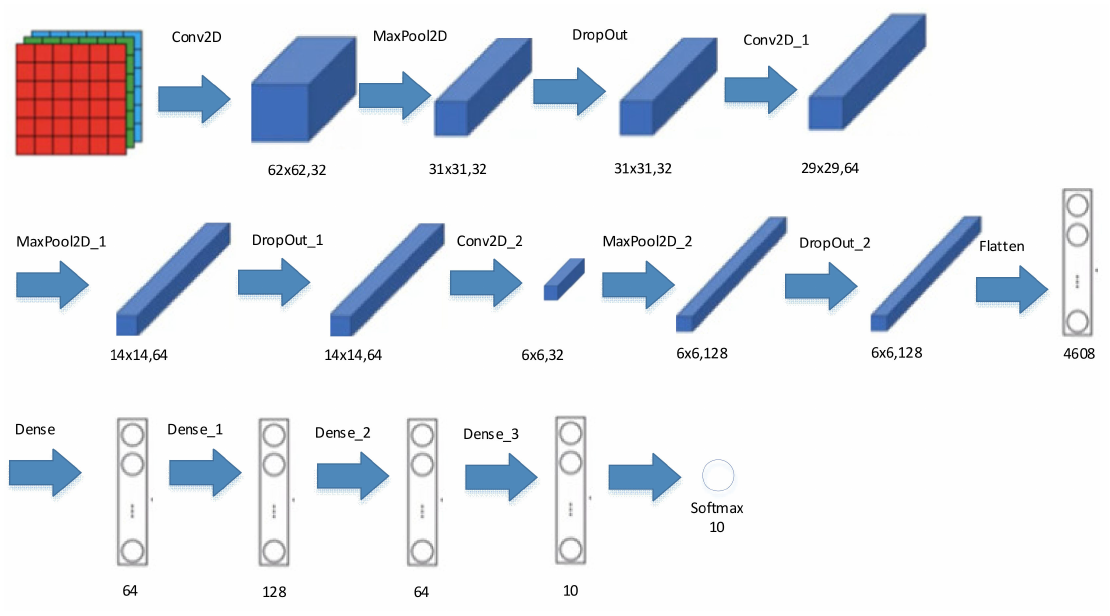
Figure 4. The AlexNet modification